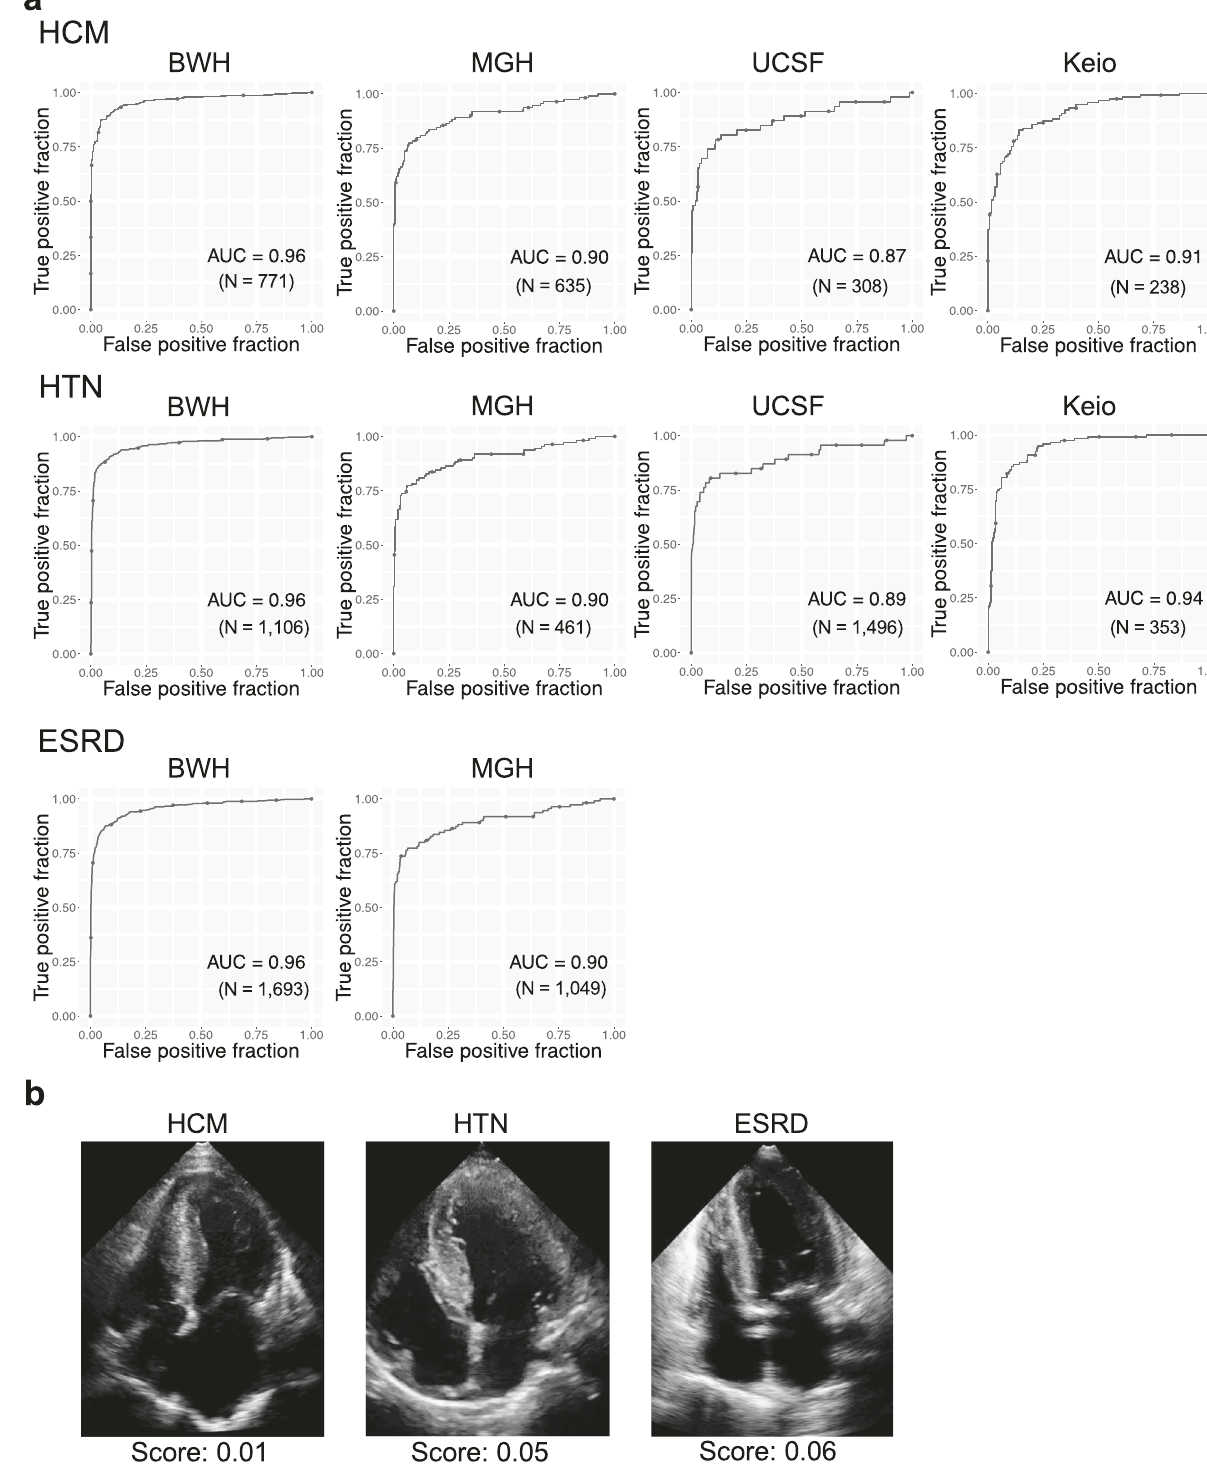
Fig. 3 Performance of the echocardiography model for discriminating cardiac amyloidosis from HCM, HTN and ESRD. a ROC plots for detecting cardiac amyloidosis for each institution. The performance on the test dataset is shown for BWH-HCM. b Representative images for selected controls for each disease. The score denotes the model output for the video. N is the numbers of studies. Source data are provided as a Source Data fi le. HCM: hypertrophic cardiomyopathy, HTN: hypertension, ESRD: end-stage renal disease. BWH: Brigham and Women ’ s Hospital, MGH: Massachusetts General Hospital, UCSF: University of California San Francisco, Keio: Keio University. AUC: area under the